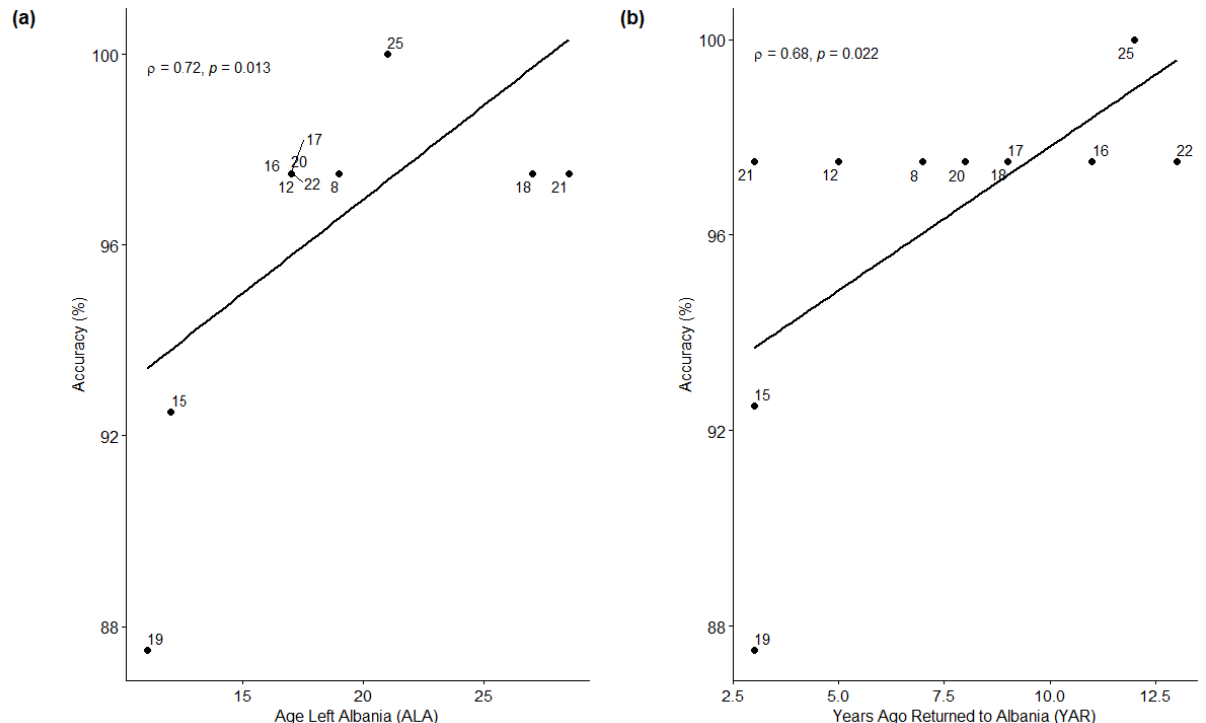
Figure 7. Scatterplots displaying the relationship between ( a ) ALA; and ( b ) YAR and percentage accuracy in the identification of laterals. Spearman’s correlation coefficient is indicated by ρ . Corre- sponding p -values are found to the right of each coefficient value.